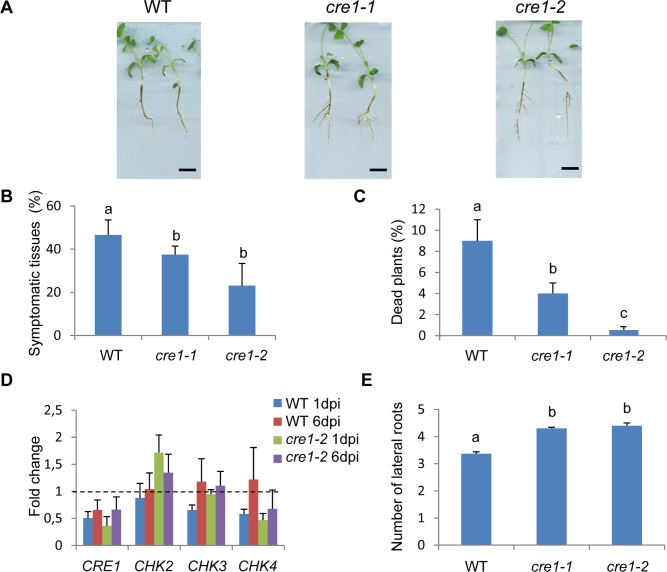

cre1 mutants resistance to Aphanomyces euteiches infection correlates with an increased lateral root formation.
A. Representative phenotypes of the Wild-Type (WT) and of the cre1 mutant (cre1-1 and cre1-2 alleles) observed 21 days post inoculation (dpi) with A. euteiches. B. Percentage of symptomatic tissues observed at 14 dpi in the Wild-Type (WT) and in the cre1 mutant (cre1-1 and cre1-2 alleles). C. Percentage of dead plants at 21 dpi in the Wild-Type (WT) and in the cre1 mutant (cre1-1 and cre1-2 alleles). D. Real time RT-PCR of putative cytokinin receptors expression (CHKs) in roots of the Wild-Type (WT) and of the cre1 mutant (cre1-2 allele), treated with A. euteiches for 1 or 6 days (dpi, days post infection). Genes of interest were normalized with the reference gene MtRBP1 and calibrated with the non-treated condition (the broken line indicates a ratio of 1). Error bars represent standard deviation of three biological replicates. E. Number of lateral roots emerged at 21 dpi in the Wild-Type (WT) and in the cre1 mutant (cre1-1 and cre1-2 alleles). In B, C and E, error bars represent confidence interval (α = 0.05; n>30) and a Kruskal-Wallis test was used (shown by letters, α<0.05).